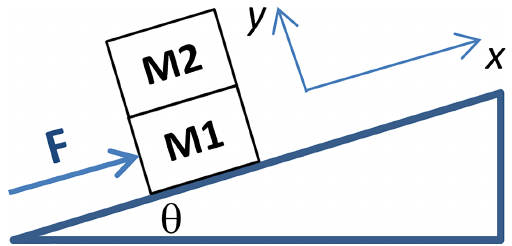
FIG. 14. Diagram provided in the prompt for version D of week 7, level 1